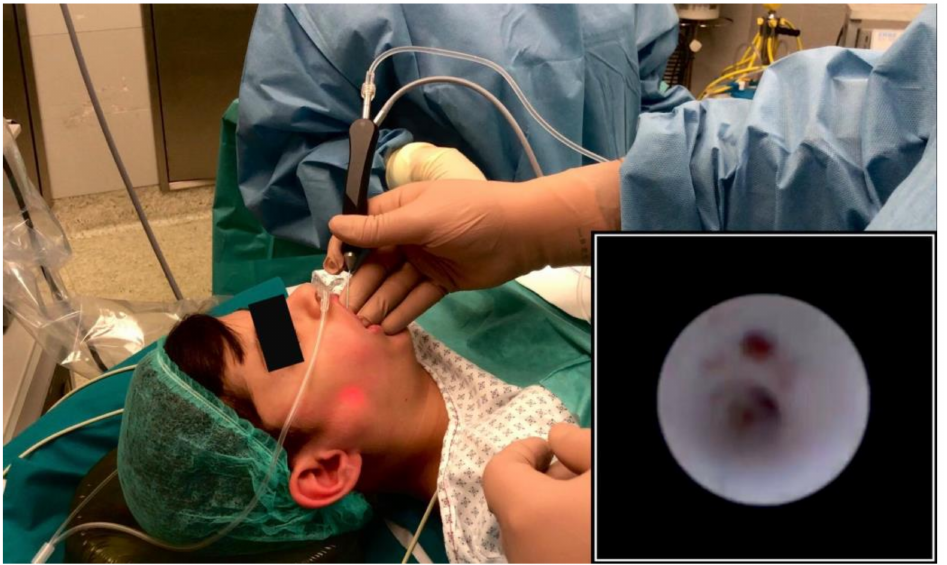
Figure 1. Transillumination of the light of the sialendoscope during parotid sialendoscopy under deep sedation; endoscopic view of the main parotid duct (picture in picture).